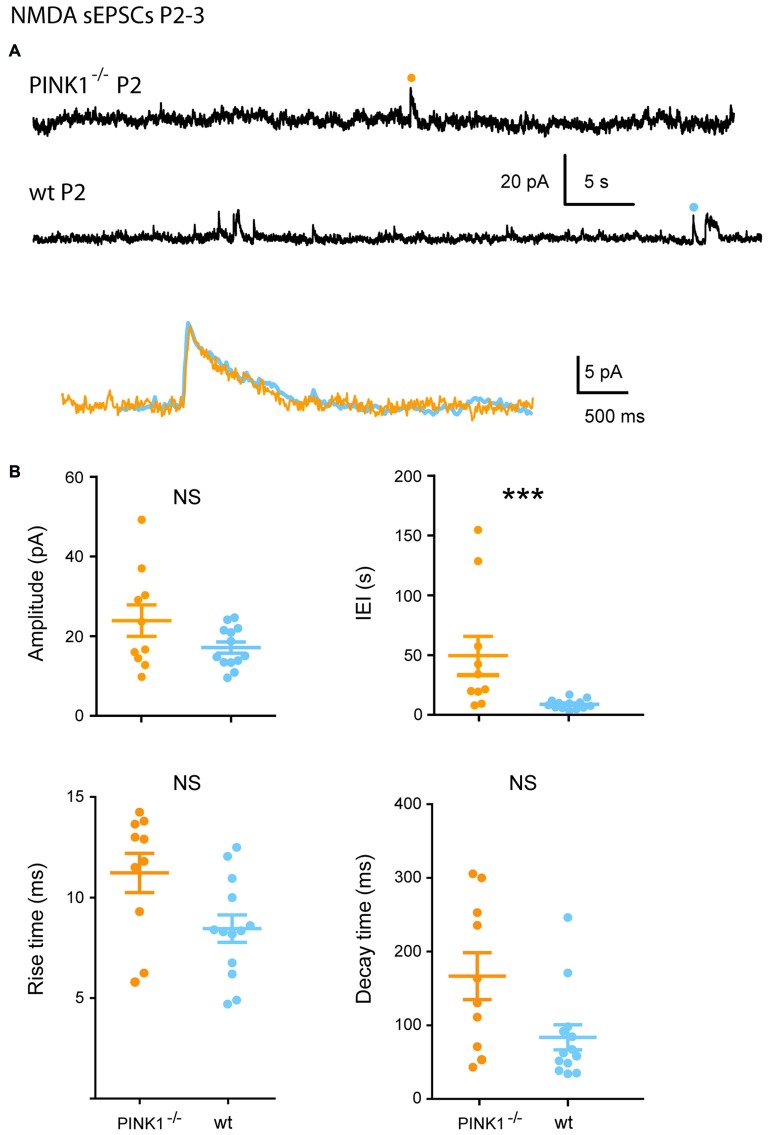
Single N-methyl-D-aspartic acid (NMDA) sEPSCs P2–3 pink1−/− SNc DA neurons and comparison with age-matched wt SNc DA neurons. (A) Voltage-clamp recordings of NMDA sEPSCs from a P2 pink1−/− (orange) and a P2 wt (turquoise blue) SNc DA neuron in the continuous presence of gabazine (5 μM) and NBQX (10 μM) at VH = +40 mV. The NMDA events indicated by a dot are enlarged and superimposed in the inset. (B) Quantification and statistical comparison of the amplitudes and IEIs and of the rise and decay times of P2–3 pink1−/− (n = 10) and wt (n = 13) NMDA sEPSCs, as indicated.